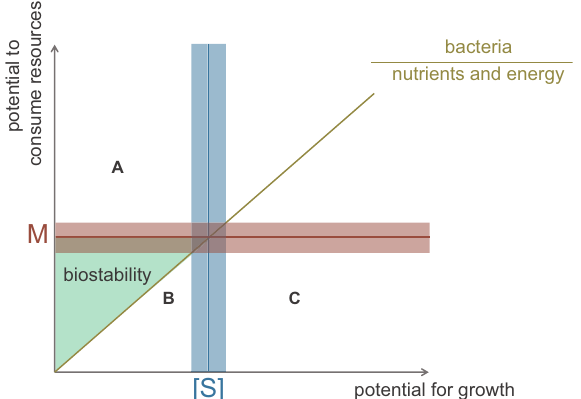
Fig. 2 The concept of biostability as a function of the potential for growth and the potential to consume resources. The potential for growth is measured as the concentration of growth-limiting factors ( x -axis), and the potential to consume resources is measured as the bacterial load ( y -axis). At a growth-limiting factor concentra- tion below the threshold [S] (blue vertical line), selection favours the K-strategists (see also Fig. 1). The microbial abundance should be close to the carrying capacity M (red horizontal line). When these two conditions are ful fi lled, the relative amount of nutrients and energy available for a bacterium ( “ per caput ” ) will be minimized (yellow diagonal line). Biostable water must comply with these three boundaries (green area). When a small change in bacterial or nutrient concentration occurs, a biostable ecosystem should be resilient (blue and red marked area around M and [S]). Three situations of biological instability are illustrated. A A bacterial load above the carrying capacity of the ecosystem will result in die-off, resulting in a release of nutrient and (necrotrophic) growth. B A too low bacterial load will result in overall regrowth. C A growth-limiting factor concentration above the K/r threshold concentration will result in regrowth of unwanted concentrations (Fig. 2, x -axis) and the total bacterial abundance (Fig. 2, y -axis) as the two main determinants for biostability.